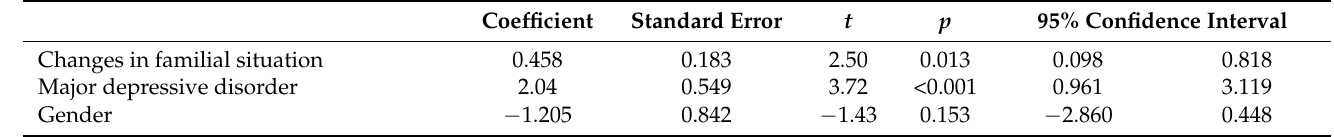
Table 4. Influence of life events of changes in familial situation on depersonalization: Multiple linear regression analysis adjusted for